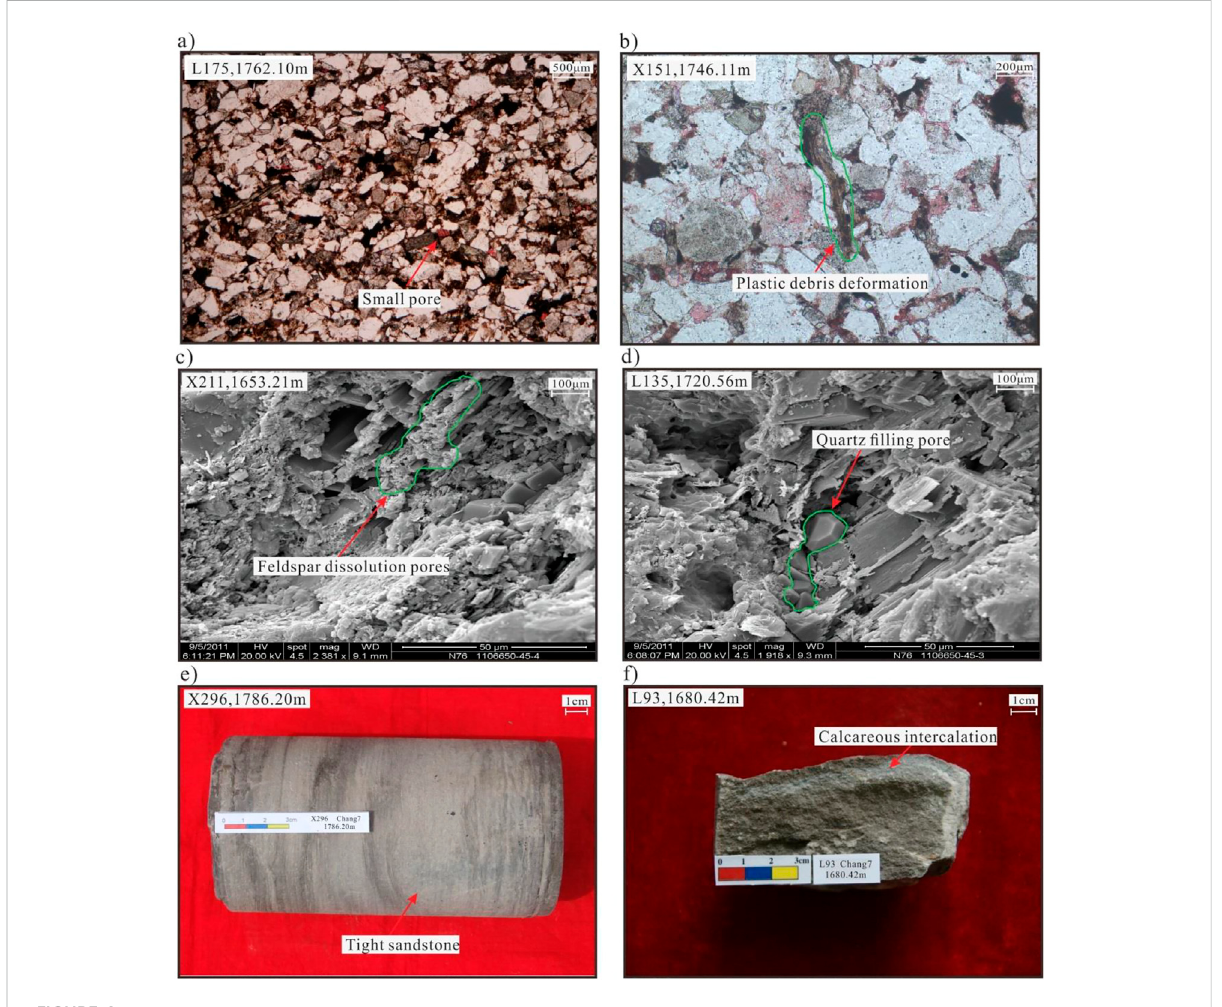
FIGURE 4 Microscopic pore structure characteristics of typical well cores. (A) Well L175, 1762.10 m; (B) Well X151, 1746.11 m; (C) Well 211, 1653.21 m; (D) Well L135, 1720.56 m; (E) Well X296, 1786.20 m; (F) Well L93, 1680.42